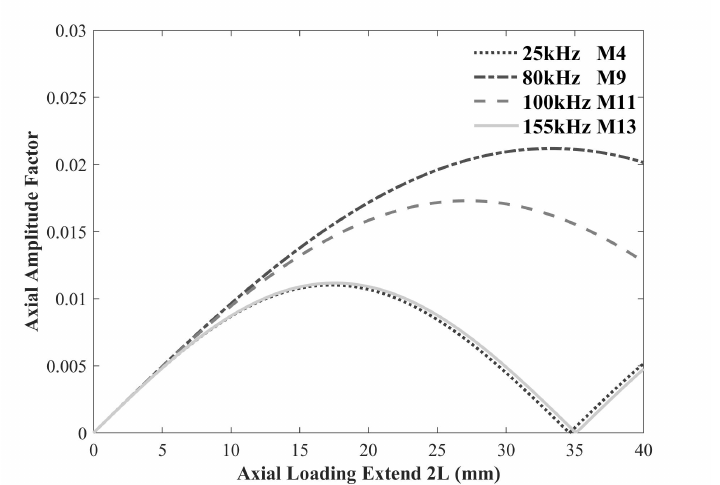
Figure 5. Axial amplitude factor varying with extending 2 L t .